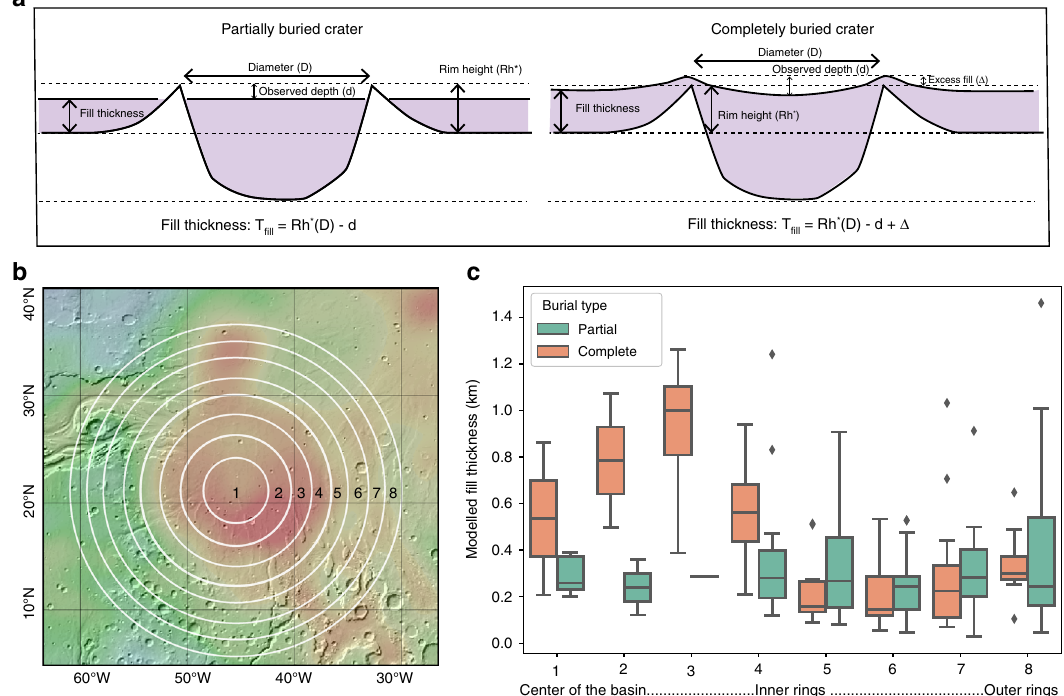
Fig. 4 The estimated thickness of fi ll based on crater morphometry in the region of Chryse Anomaly unit. a Schematics of the morphological parameters used to calculate fi ll thickness for partially and completely buried craters. b Geographic locations of the regions for the calculation of impact crater thickness in c , with Mars Bouguer gravity anomaly as the base map 20 . c Variation of the calculated fi ll thickness with distance to the center of the anomaly. The colored box indicates the range of values from the lower to upper quartile for each column, with a black horizontal line at the median value. The whiskers extending from the box show the total range of the data, except for outlier points which are indicated using black